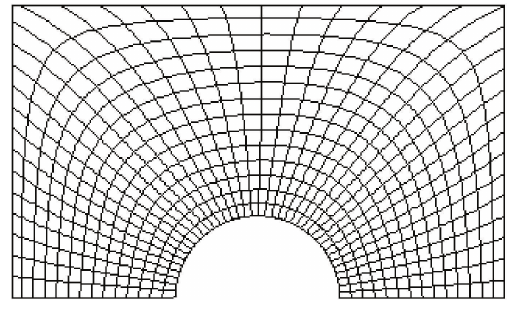
Figure 1: Calculation